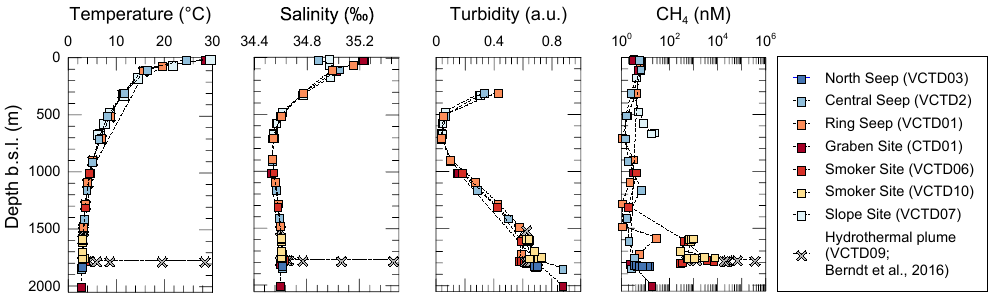
Figure 6. Water column temperature, salinity, turbidity, and methane concentrations. Note that the upper ∼ 300m below sea level (b.s.l.) in the turbidity data are not shown for scale matters. VCDT09 and temperature data from VCDT10 are from Berndt et al. (2016), all other parameters were acquired in this study.